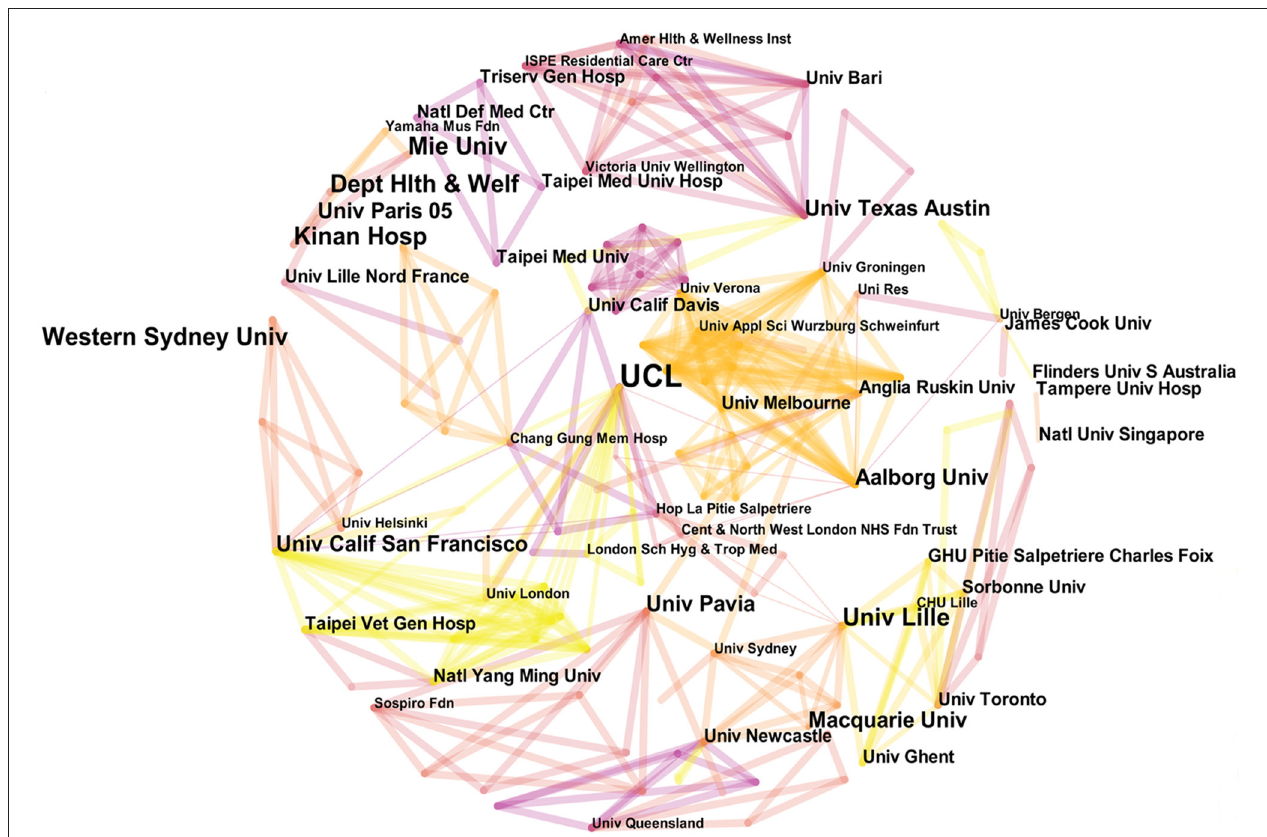
FIGURE 5 | Academic collaboration between different institutions in the field of music therapy for dementia.